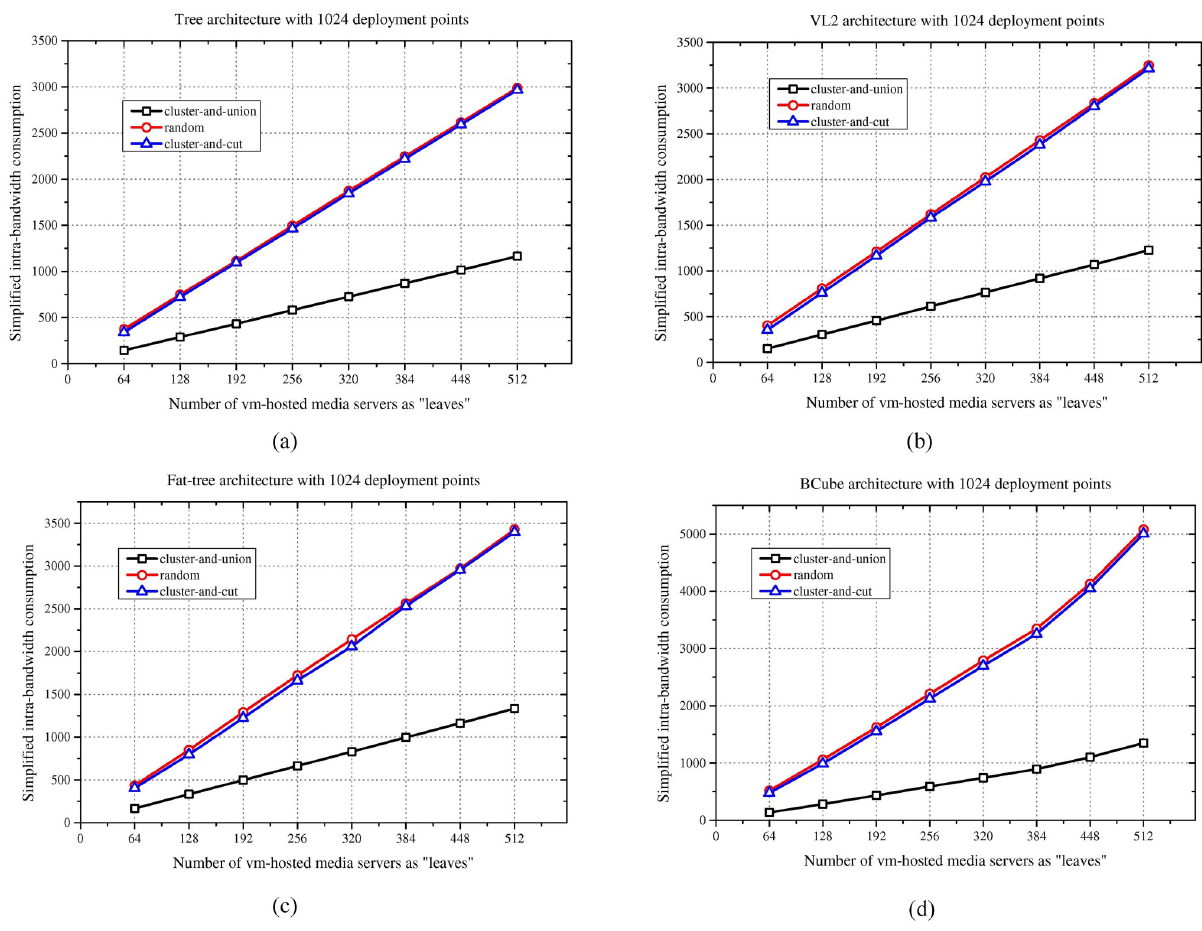
Fig 3. Intra-bandwidth consumption results for different scales of the media server cluster. (a) Tree. (b) VL2. (c) Fat-tree. (d)